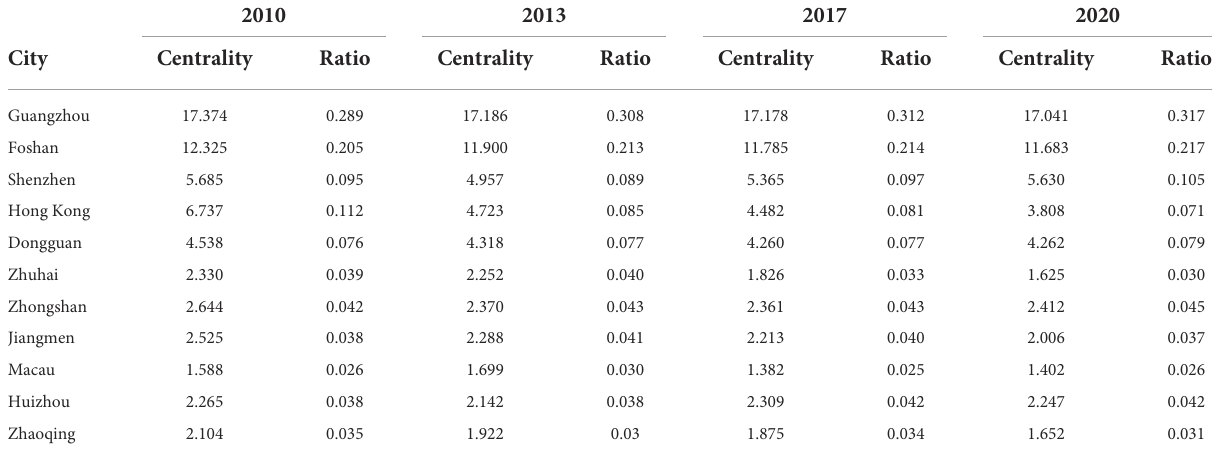
TABLE 1 Node centrality of the